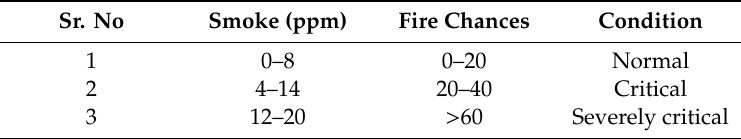
Table 8. Experimental analysis of Smoke